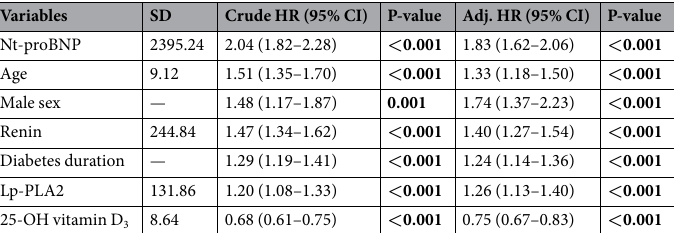
Table 1. Unadjusted and adjusted effects on all-cause mortality. Cox proportional hazard model of variables selected by bootstrapping. Hazard ratios (HR) refer to a 1-SD increase in continuous variables, a reduction in one category of LVEF and a increase in one category of diabetes duration. HRs are adjusted (adj.) for all variables selected by bootstrapping i.e. for male sex, age, pro-BNP, HbA1c, renin, 25-OH vitamin D 3 , and lipoprotein associated phospholipase A2 (Lp-PLA2). SD – standard